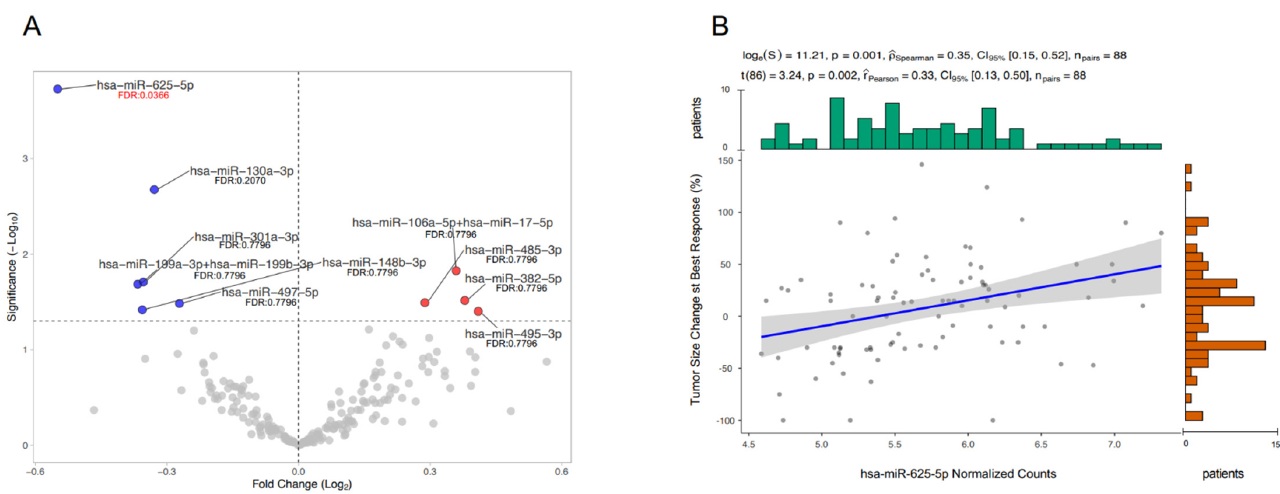
Figure 1. Di ff erential EV − miRNAs’ expression based on the Objective Response. Volcano Plot shows miRNAs significantly overexpressed on the right (red dots) and miRNAs significantly downregulated on the left (blue dots) ( A ). Scatter plot representing the correlation between miR-625-5p levels and tumor size change at best response ( B ).